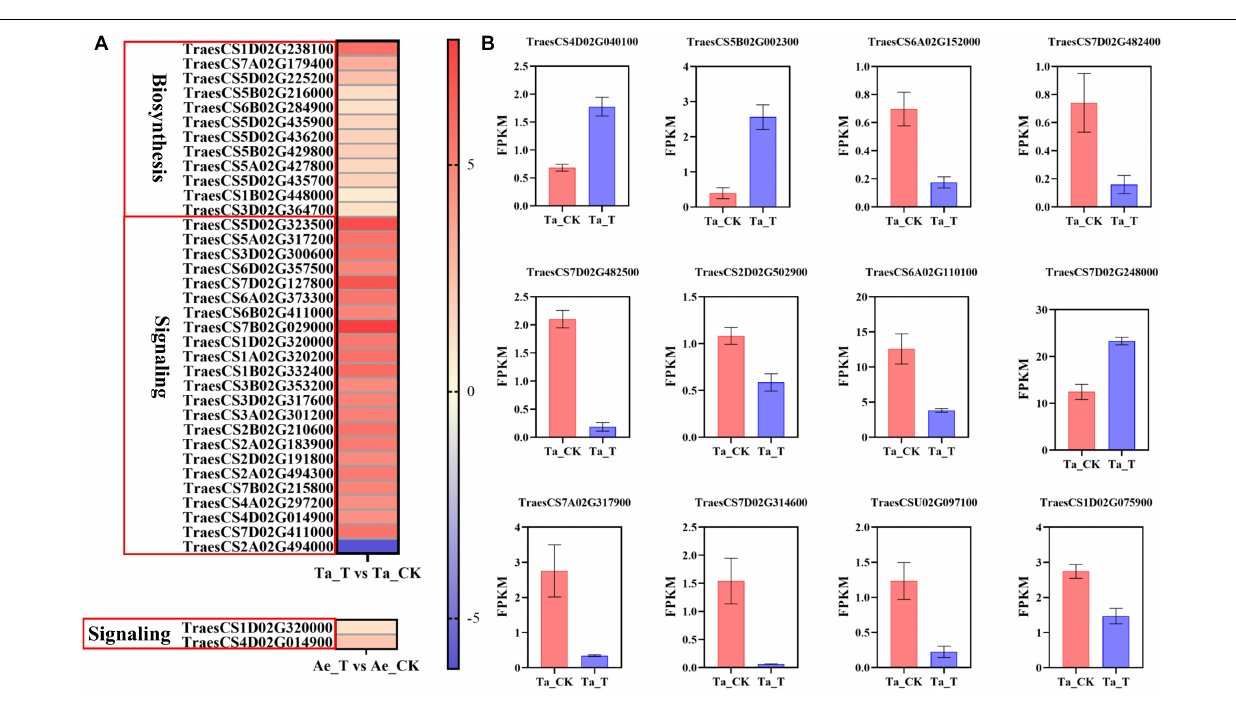
considered candidate genes that might be related to